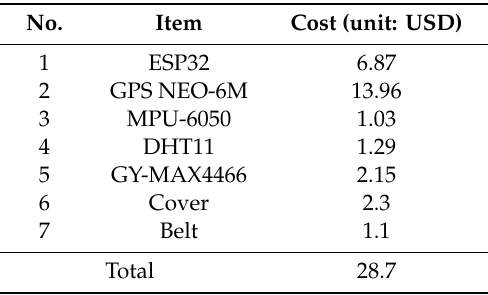
Table 2. Cost of the materials individually.